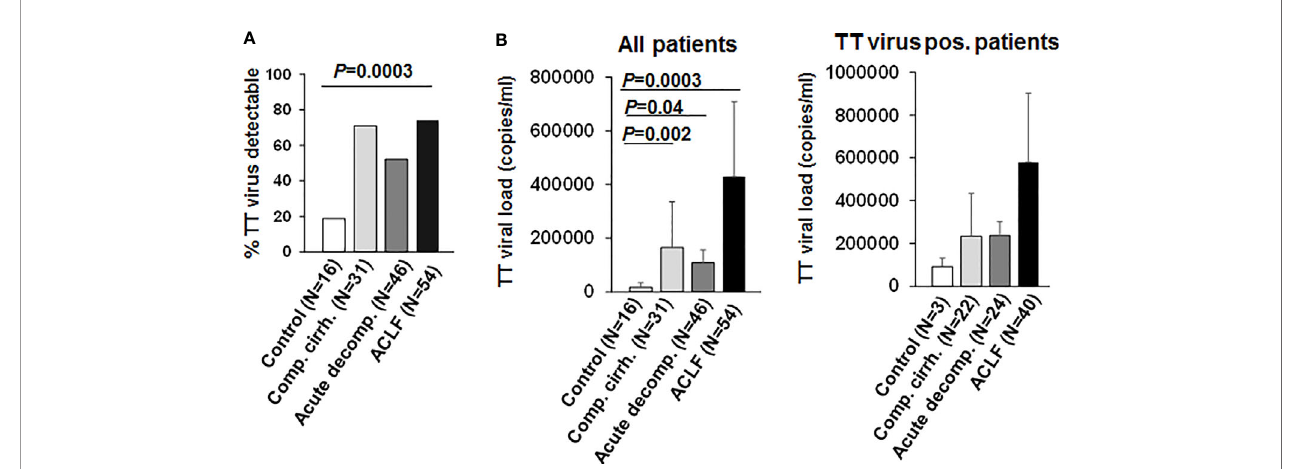
FIGURE 1 | TT virus is frequently detectable in patients with liver cirrhosis. (A) Frequencies of detectable TT virus DNA according to the stage of liver disease are shown in comparison to healthy controls. (B) Mean quantitative measurement of TT viral load according to the stage of liver disease are shown for all patients (left graph) and for the subgroup of individuals with detectable TT virus (right